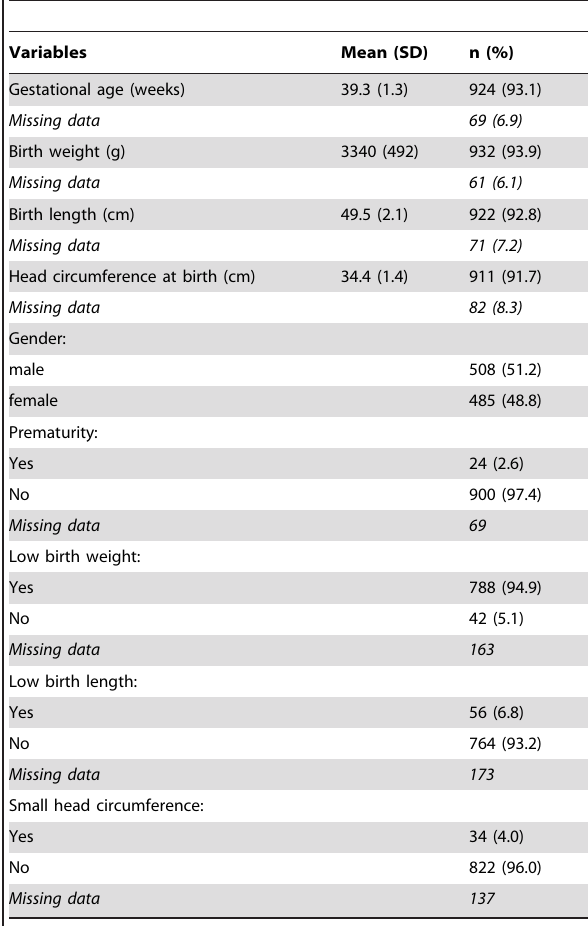
Table 2. Newborn characteristics in the MecoExpo cohort